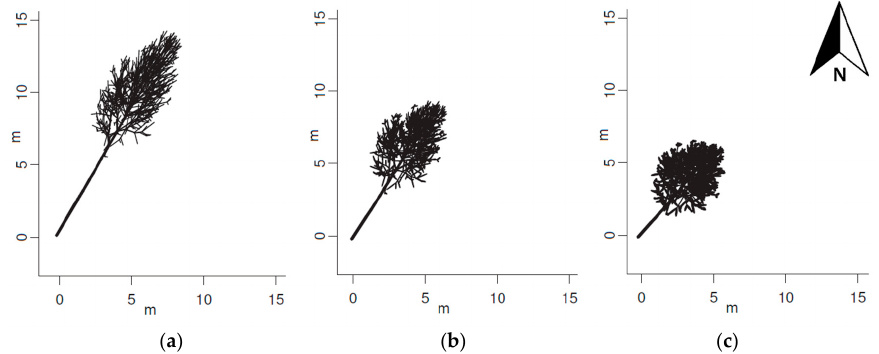
Figure 3. The shadows of the tree model at three points in time with different stages of ellipsoids at 12:00 am: ( a ) 15 March (no ellipsoids); ( b ) 15 April (2 cm ellipsoid width); ( c ) 15 July (5 cm ellipsoid width).